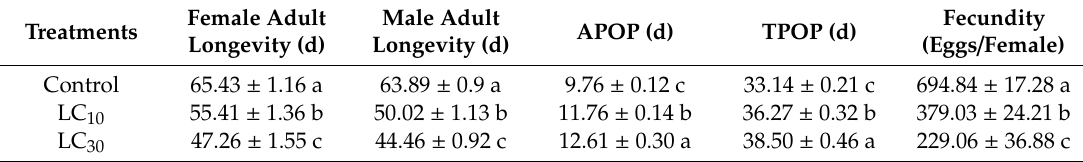
Table 3. Sublethal e ff ects of chlorpyrifos on the life parameters (mean ± SE) of H. axyridis adults treated with insecticide from the third instar larval